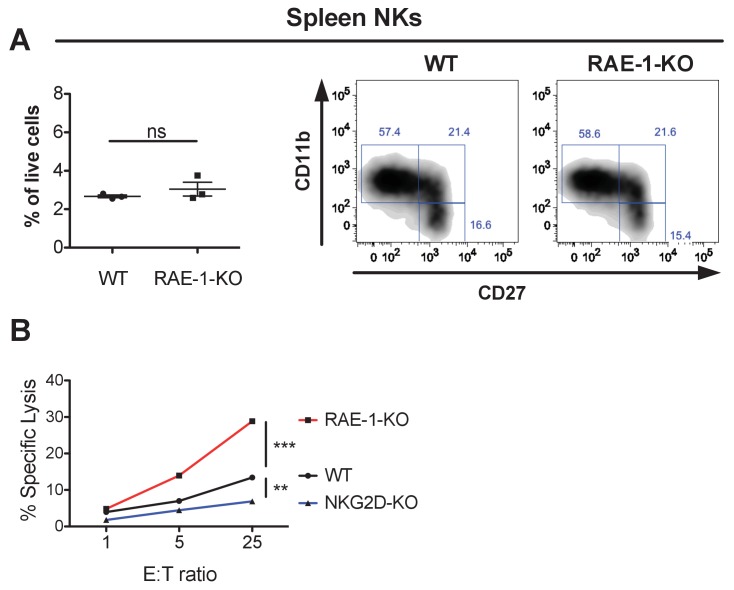
Normal NK cell cellularity and differentiation but enhanced NK-mediated tumor cell killing in RAE-1-knockout mice.(A, left panel) NK cells from WT and RAE-1-KO mice as percentage of live splenocytes. Data are representative of >4 independent experiments. (A, right panel) CD27 and CD11b expression on splenic NK cells from WT and RAE-1-KO mice. Data are representative of three independent experiments. (B) NK cells from WT, RAE-1-KO, or NKG2D-KO mice (n = 3) were pre-activated with a single injection of 200 g Poly I:C. Two days later, peritoneal wash cells were harvested, pooled, and used as effector cells to kill YAC-1 cells in a standard 51Cr in vitro cytotoxicity assay, at the indicated effector: target ratios. Data are representative of two independent experiments. Statistical significance was determined using unpaired two-tailed Student’s t tests (A) or two-way ANOVA (B). Data represent means ± SEM (error bars are not visible because they are small).